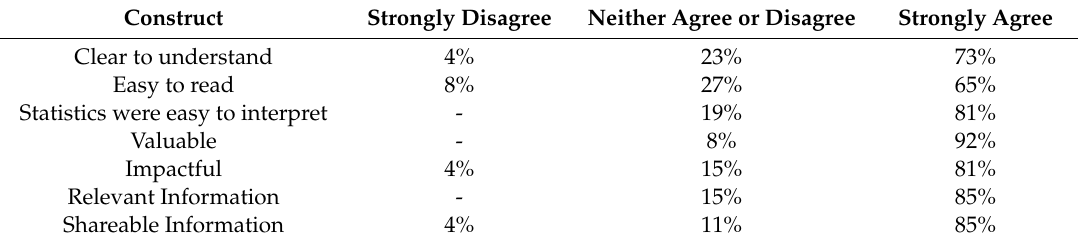
Table 2. Frequency table (as a percentage) of participants’ interpretations of the eB4CAST food insecurity